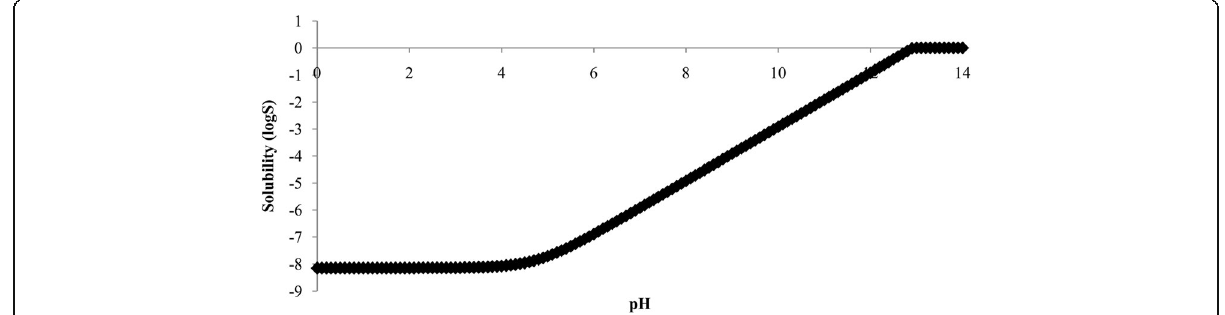
Fig. 7 Solubility (logS) of betulinic acid over the pH range of 0.0 to 14.0